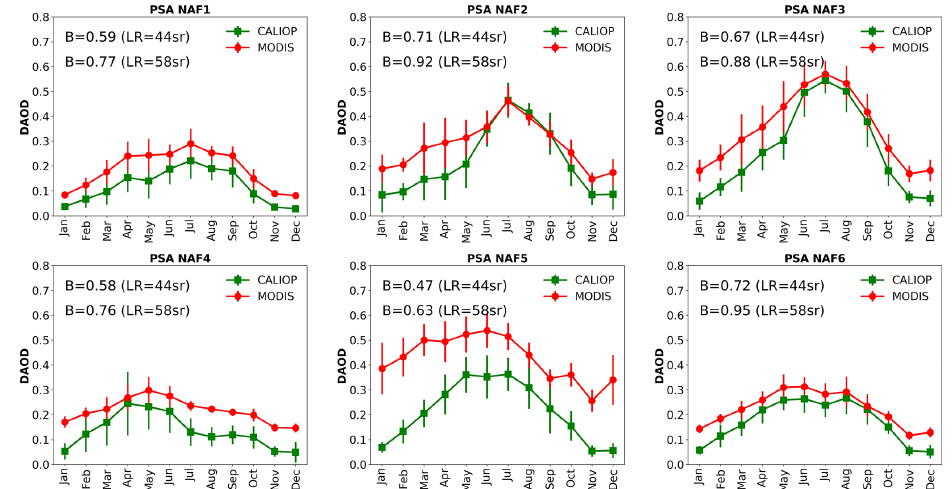
Figure 13. Annual cycle of 13-year (2007–2019) monthly mean DAOD over the six PSAs of north African dust. The CALIOP DAOD annual cycle shown in the figure is derived from backscatter coefficients using LR of 44sr. The mean bias ( B ) is computed as the average of CALIOP DAOD/MODIS DAOD ratios of all data pairs. B = 1, > 1, and < 1 indicate no bias, high bias, and low bias. The mean bias ( B ) associated with CALIOP DAOD based on LR = 44 and 58sr is shown in the upper left of each